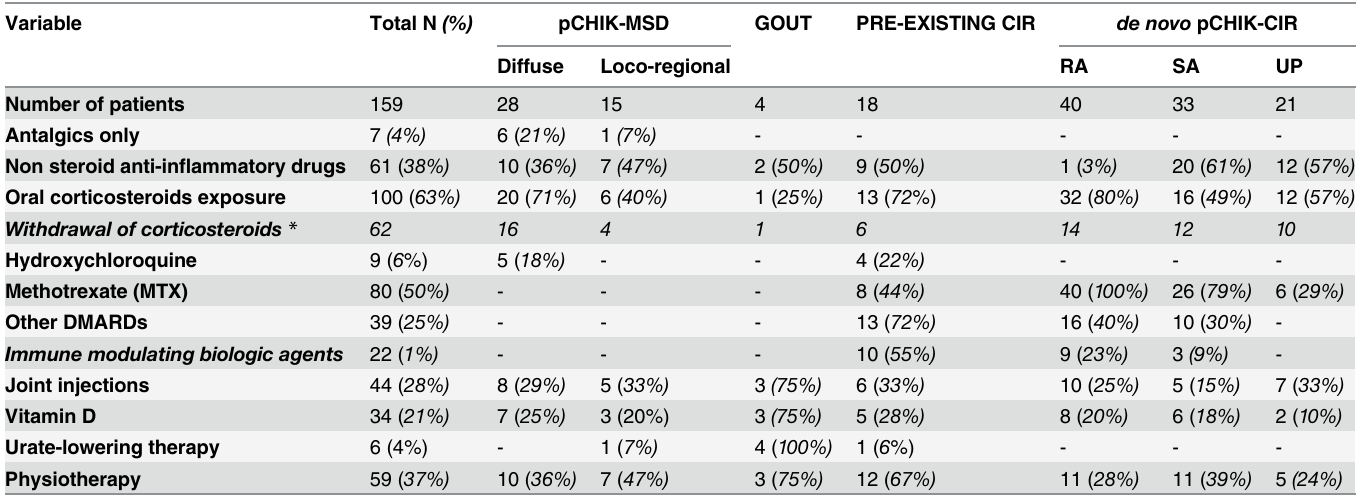
Table 3. Treatment history of patients referred to a rheumatologist for rheumatic or musculoskeletal pains persisting after a con fi rmed chikungunya infection, Saint Denis, Reunion Island, 2006 –